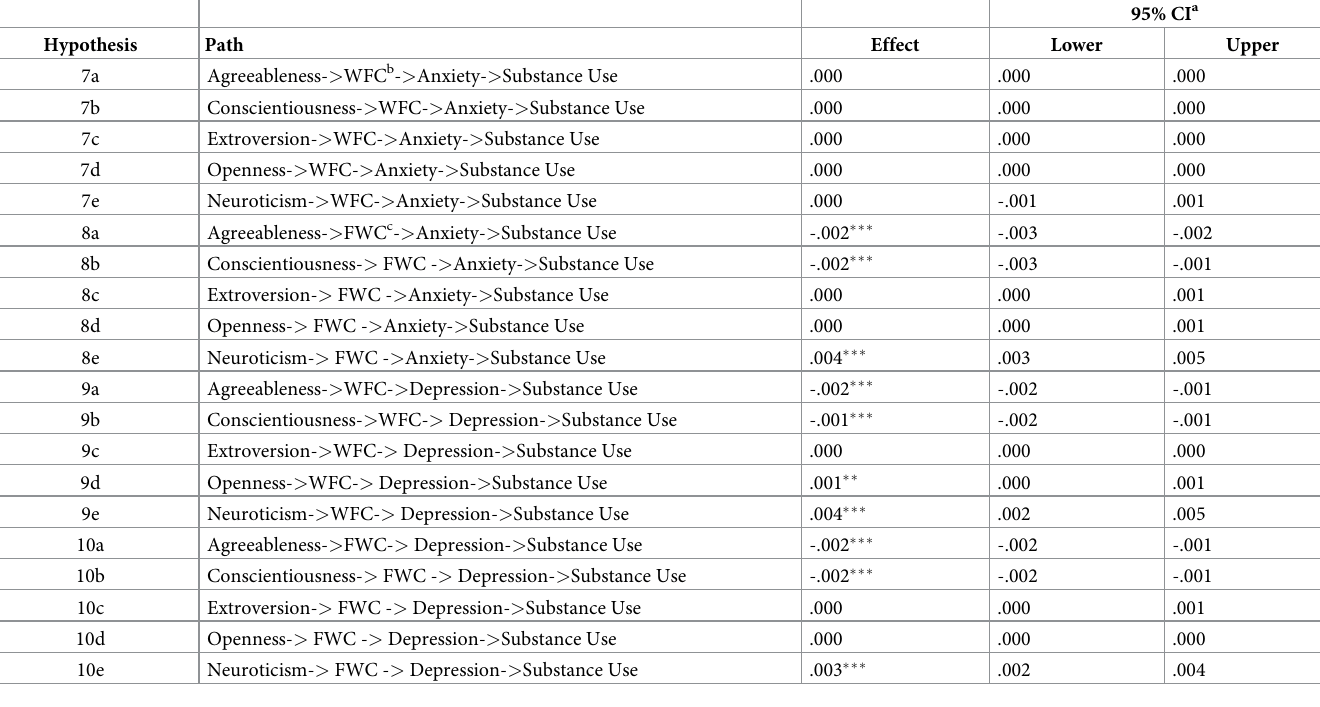
Table 4. Results for sequential